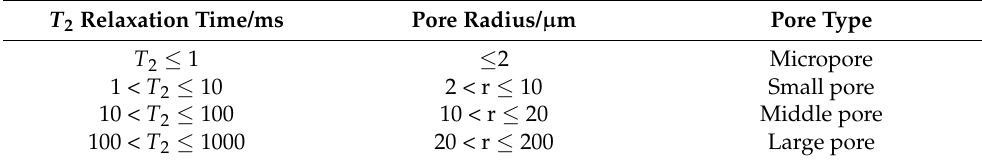
Table 2. Corresponding relationship between relaxation time and pore radius. T 2 Relaxation